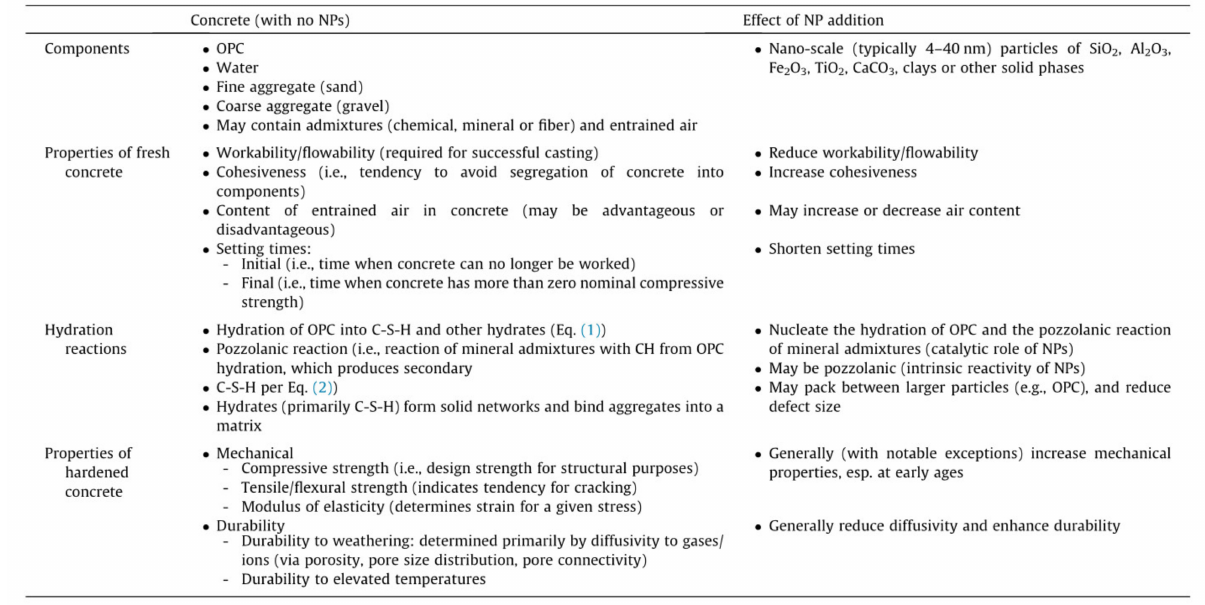
Figure 8. Impact of nanoparticles on concrete